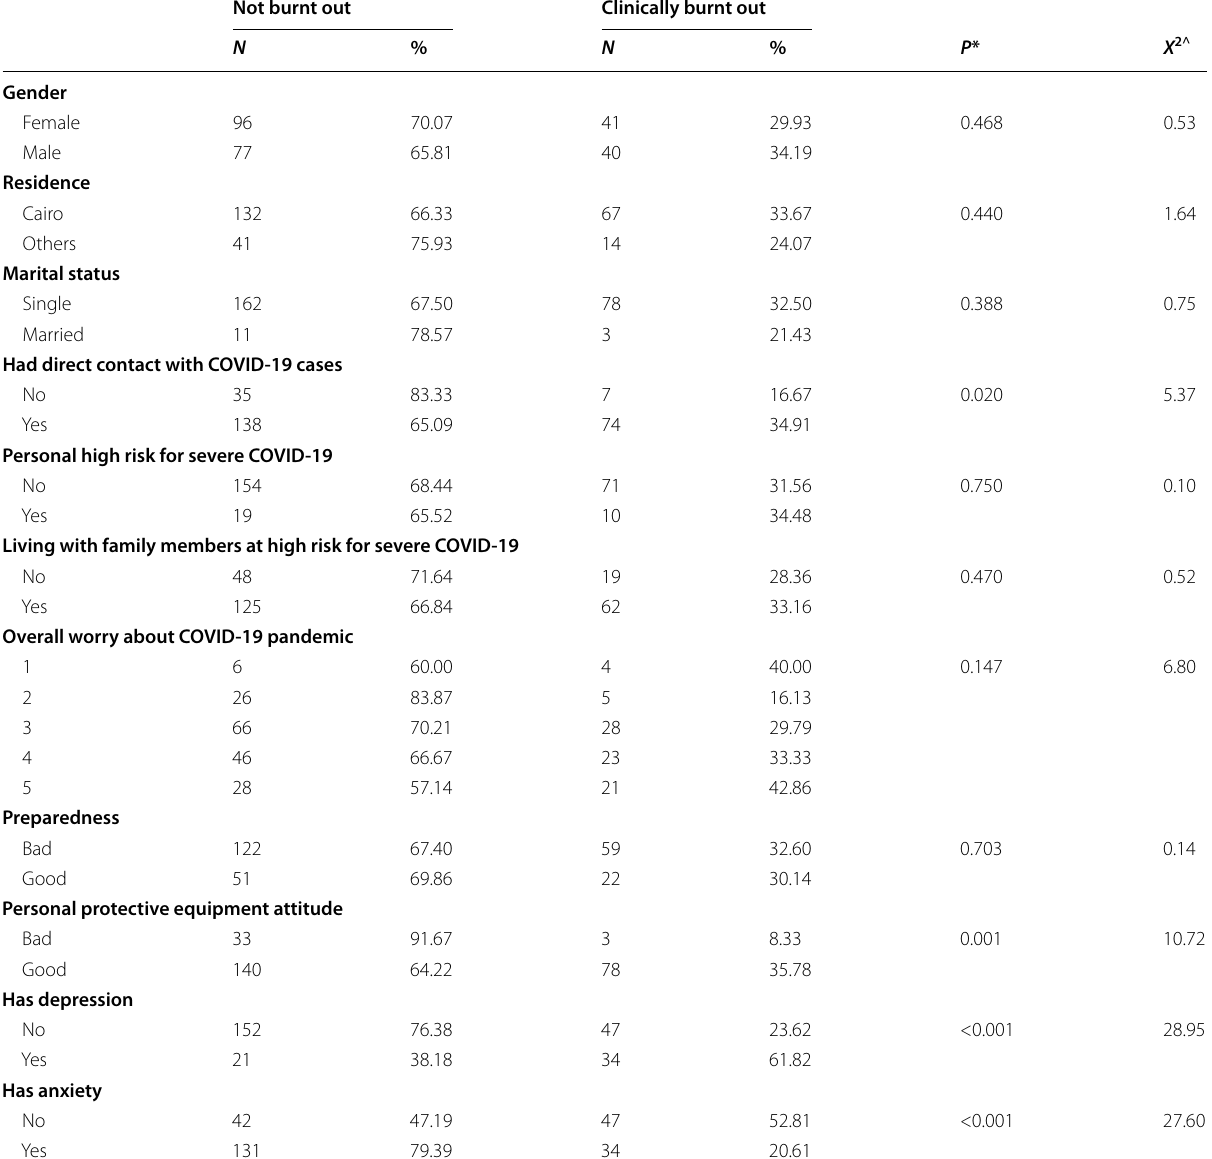
Table 4 Bivariate association between characteristics of the study population and burnout ( N